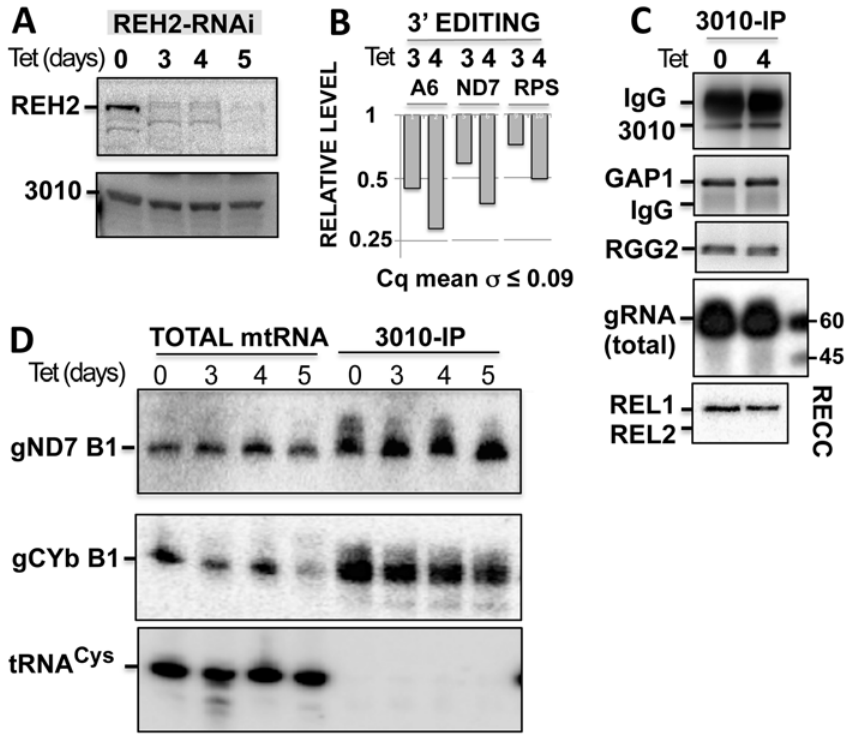
Fig 3. REH2 knockdown affects editing by the initiating gRNA in 3010-MRB but not 3010 association with common MRB1 proteins, gRNA or RECC. (A) Western blots of REH2 and 3010 in lysates of induced cells with tetracycline (Tet). Full length and proteolytic fragments of REH2 are detected in all Figs in this study. (B) Relative level of early 3 ’ editing in block 1 of mRNAs A6, ND7, and the first few blocks in RPS12 (RPS). RT-qPCR assays were performed in cell lysates using tubulin as the reference. Uninduced samples are set at 1. (C) 3010-IPs of mitochondrial extracts at 0 or 4 days post-induction in western blots of 3010 and GAP1, or radiolabeled capping (gRNA) and autoadenylation (editing ligases REL1/2). (D) Northern blots of initiating gRNAs for block 1 (B1), gND7 (1269 – 1319), and gCYb gCYb (54 – 91) in total mtRNA and 3010-IPs at multiple time points of RNAi induction. The blots were stripped and reprobed for tRNA-Cys, showing that the pulldowns are specific for